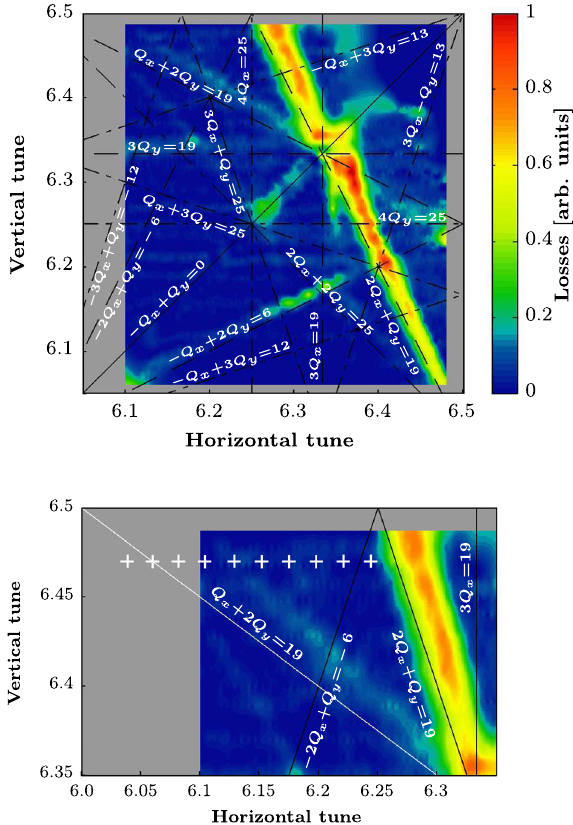
FIG. 1. Top: Experimental tune scan at 2 GeV kinetic energy. The color scale is proportional to the measured normalized beam loss. The red color indicates maximum beam loss. Solid lines indicate 2nd order, dashed lines 3rd order, and dash-dotted lines 4th order resonances. The resonance 2 Q x þ Q y ¼ 19 was found to be strongly excited by natural nonlinear errors of the machine. Greyareasindicate the absence ofmeasurement data [23].Bottom: Detail of the tune diagram shown in Fig. 1, with identical colour scale. The sextupolar resonance Q x þ 2 Q y ¼ 19 is shown with a white solid line and the working points used for the systematic study are indicated with the white